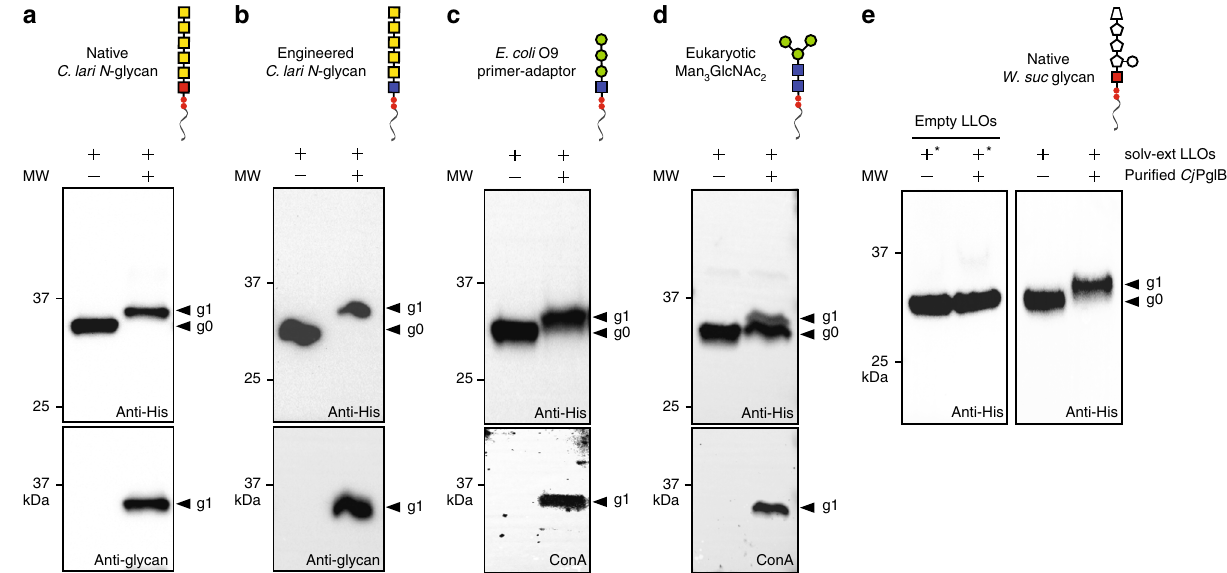
Fig. 3 Expanding cell-free glycosylation with different oligosaccharide structures. Western blot analysis of in vitro glycosylation reaction products generated with puri fi ed scFv13-R4 DQNAT acceptor protein, puri fi ed Cj PglB, and organic solvent-extracted (solv-ext) LLOs from cells carrying: a plasmid pACYC pgl4 for making the native C. lari hexasaccharide N- glycan; b plasmid pACYC pgl2 for making the engineered C. lari hexasaccharide N- glycan; c plasmid pO9-PA for making the E. coli O9 ‘ primer-adaptor ’ Man 3 GlcNAc structure; d plasmid pConYCGmCB for making the eukaryotic Man 3 GlcNAc 2 N- glycan structure; and e fosmid pEpiFOS-5 pgl5 for making the native W. succinogenes hexasaccharide N- glycan. Reactions were run at 30°C for 16h. Blots were probed with anti- His antibody to detect the acceptor protein and one of the following: hR6 serum that cross-reacts with the native and engineered C. lari glycans or ConA lectin that binds internal and non-reducing terminal α -mannosyl groups in the Man 3 GlcNAc and Man 3 GlcNAc 2 glycans. Because structural determination of the W. succinogenes N- glycan is currently incomplete, and because there are no available antibodies, the protein product bearing this N- glycan was only probed with the anti-His antibody. As an additional control for this glycan, we included empty LLOs prepared from the same host strain but lacking the pEpiFOS-5 pgl5 fosmid (left hand panel, “ + ” signs marked with an asterisk). Arrows denote aglycosylated (g0) and singly glycosylated (g1) forms of the scFv13-R4 DQNAT protein. Molecular weight (MW) markers are indicated at left. Results are representative of at least three biological